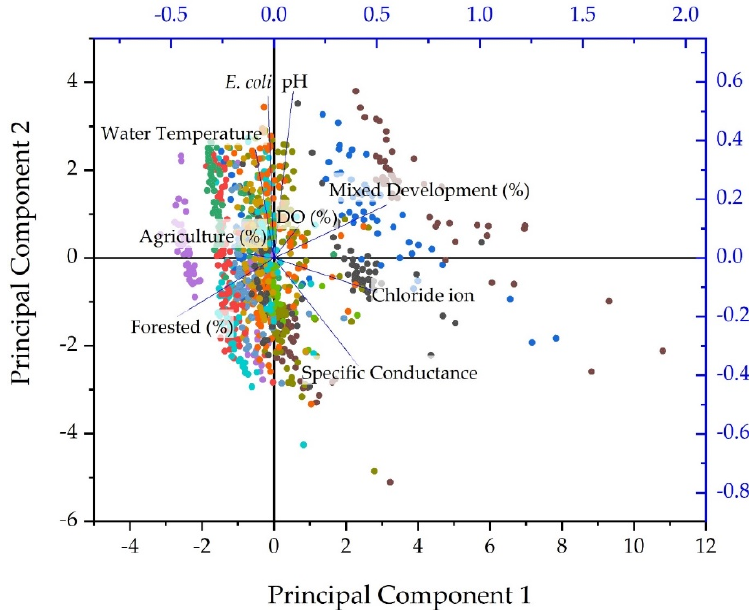
Figure9. Resultsofprincipalcomponentsanalysis, includingbiplots, forextractedprincipalcomponents Figure 9. Results of principal components analysis, including biplots, for extracted principal of annual E. coli concentration (CFU per 100 mL), water temperature ( ◦ C), pH, specific conductance components of annual E. coli concentration (CFU per 100 mL), water temperature (°C), pH, specific ( µ S / cm), dissolved oxygen (DO; %), and chloride ion (mg / L) at 22 monitoring sites (indicated by the conductance (µS/cm), dissolved oxygen (DO; %), and chloride ion (mg/L) at 22 monitoring sites di ff erent colors) during study period (2 January 2018–1 January 2019) in West Run Watershed, West (indicated by the different colors) during study period (2 January 2018–1 January 2019) in West Run Virginia, Watershed, West Virginia, USA.